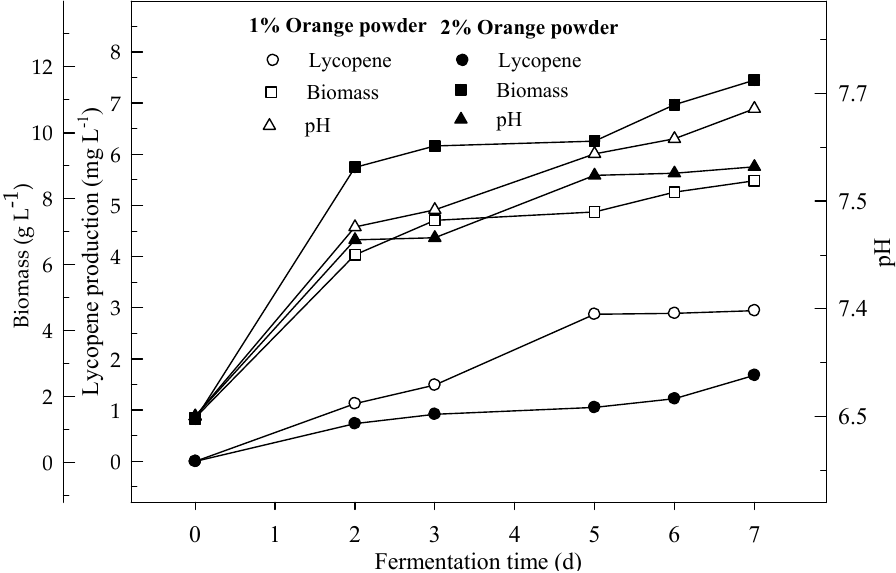
Figure 5. Changes in lycopene production, biomass formation and pH in a shake-flask fermentation with an initial pH 6.5 in a medium containing 1 and 2% orange powder.